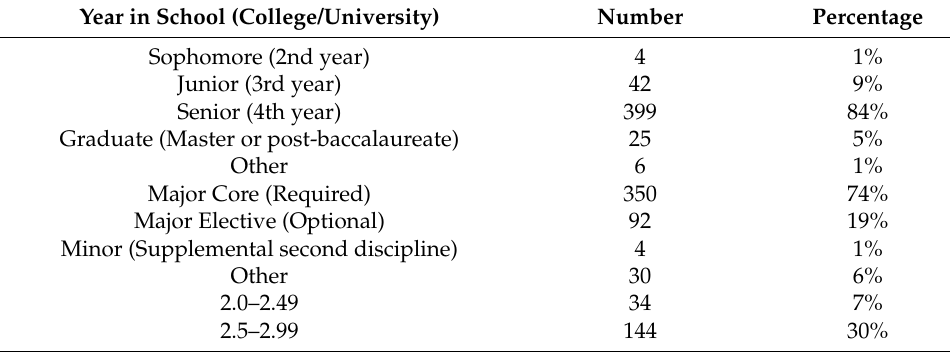
Table 6. Summary of survey pool